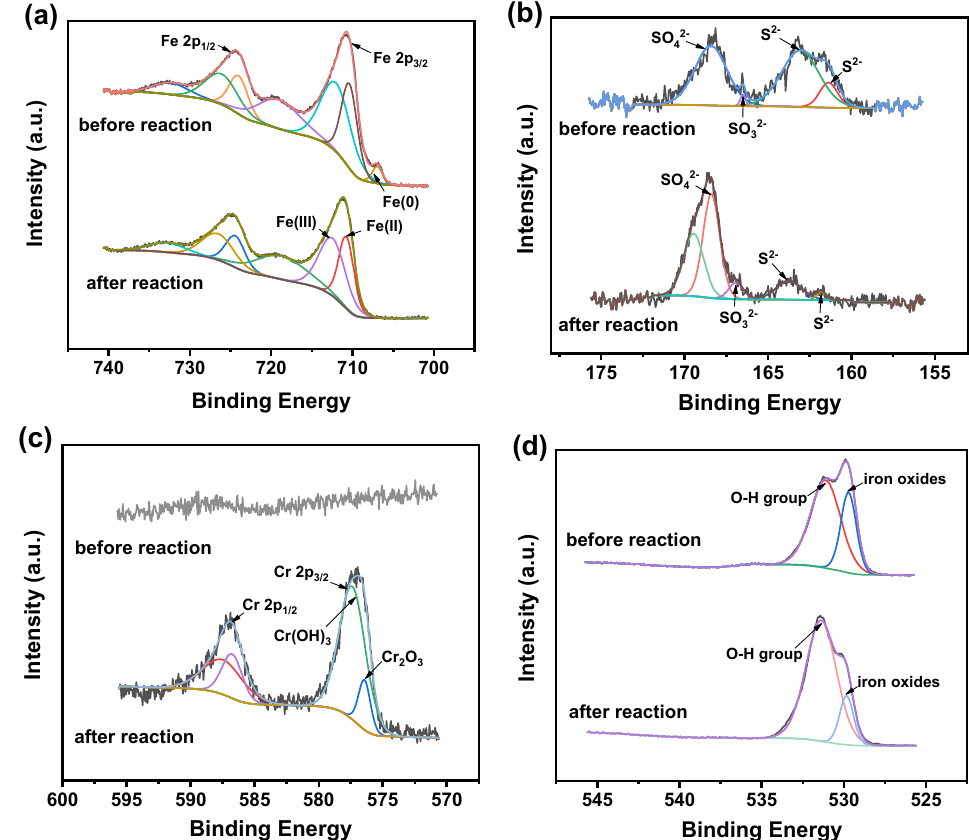
Figure 4. XPS spectra of ( a ) Fe 2p, ( b ) S 2p, ( c ) Cr 2p, ( d ) O 1 s of S ‐ nZVI before and after the reaction.